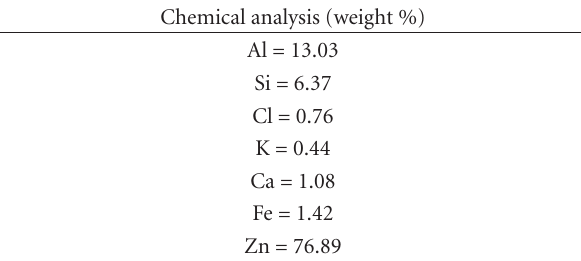
Table 6: Chemical analysis of the right